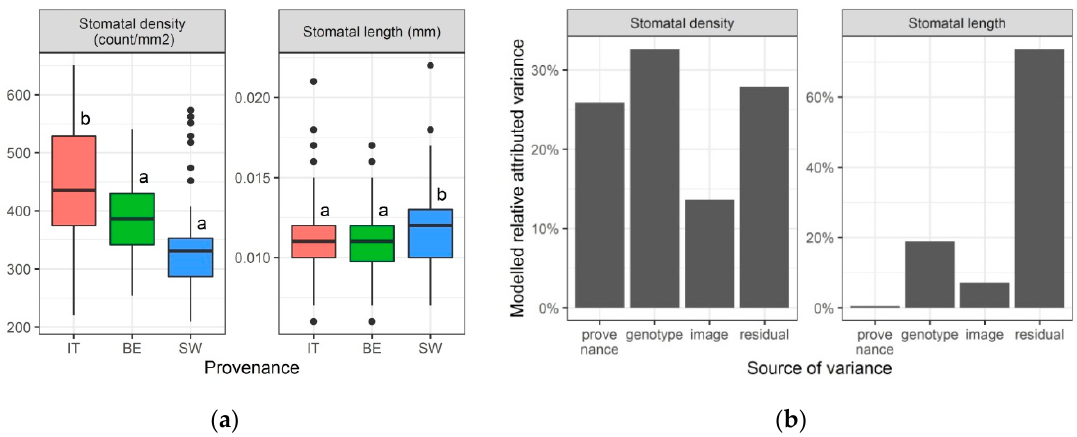
Figure 4. Stomatal traits in the control plants. ( a ) Box plots for stomatal density and stomatal length. Letters indicate significant differences (Table S2); ( b ) Modelled distribution of the relative variance. Variance is explained by the factors provenances, genotypes within a provenance and the three nail varnish prints per genotype (image), for both the stomatal traits. IT: Italian provenance, BE: Belgian provenance, SW: Swedish provenance.